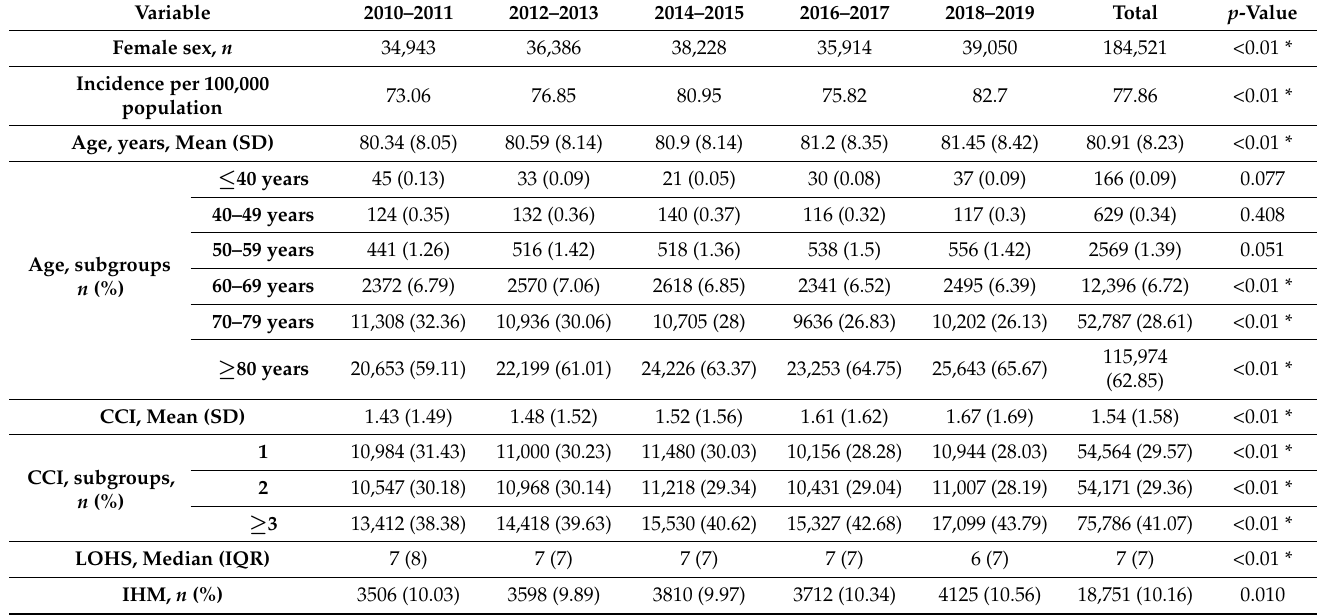
Table 5. Characteristics of Hospital Admissions of Female Patients with Parkinson ´ s Disease as a Secondary Diagnosis in Spain